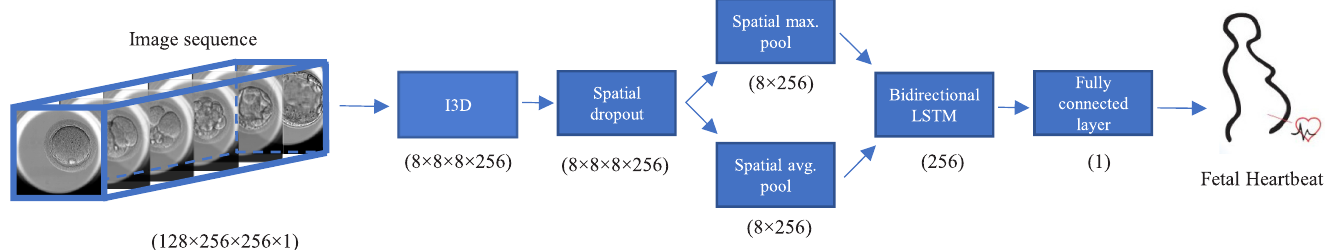
Fig 1. Overall architecture of the deep learning network used for prediction of fetal heartbeat. The image sequence is fed to a 3D CNN based on the I3D architecture. The output from the CNN is reduced in dimensions and fed to an LSTM network to utilize temporal information. Finally, a fully-connected layer predicts the fetal heartbeat. The numbers in the figure show the output dimensions from each step in the sequence.